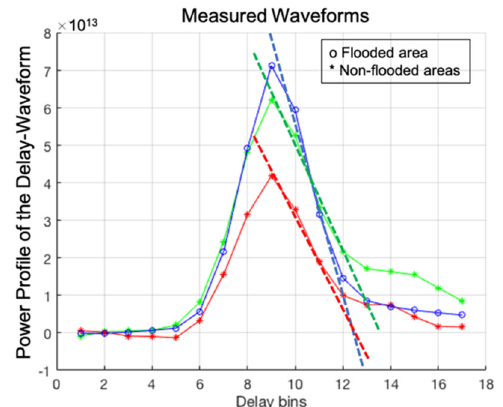
Figure 1. Example of waveforms obtained from the area under observation for different flooding conditions. Each waveform has a dashed-line representing the trailing edge marked in the same color. Three pixels in a scene were selected randomly: one (blue) within an area where inundation was reported and two within an area to the north-west of Arkansas where no reports were received (red and green).